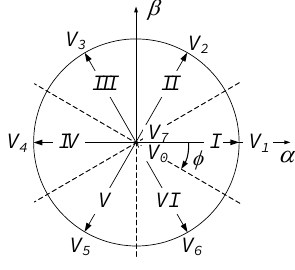
Figure 3. Six sectors in the two-phase static reference frame.